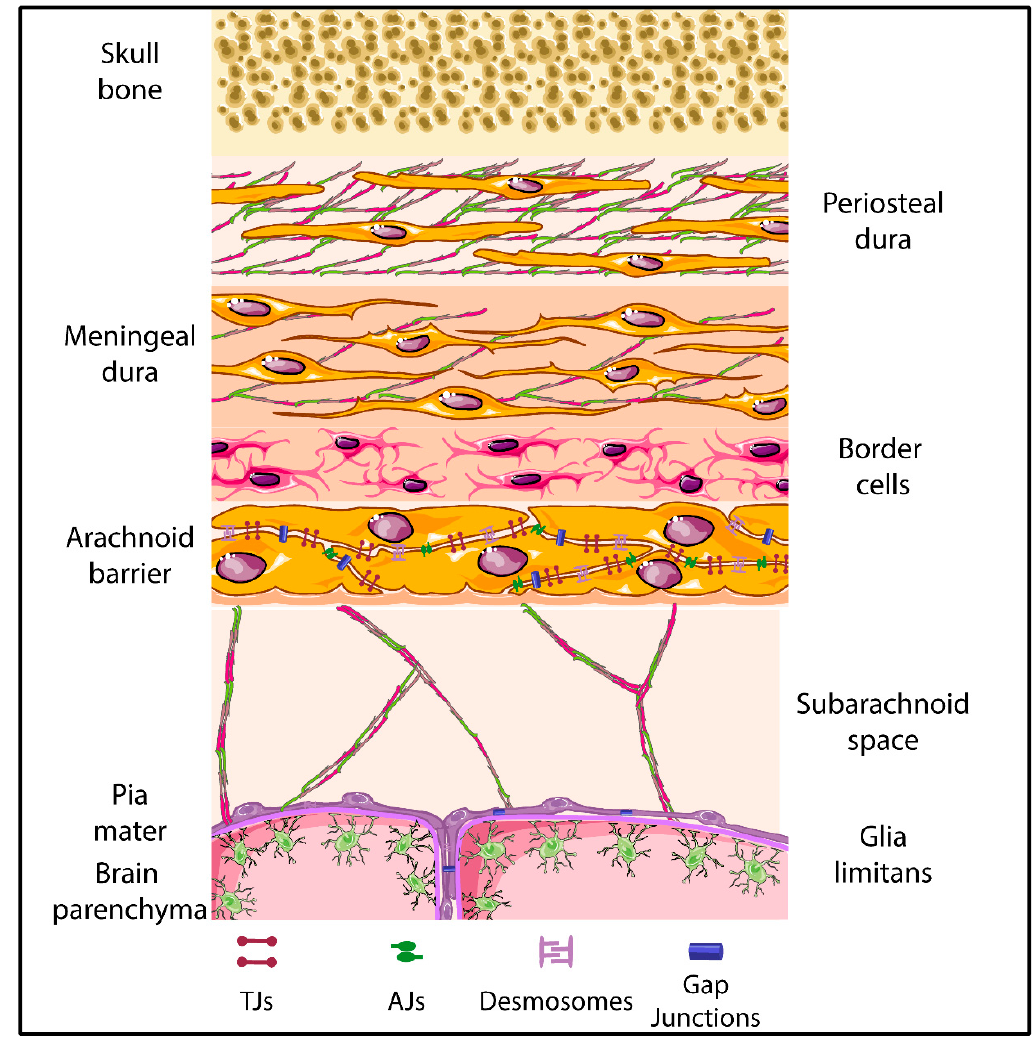
Figure 4. Schematic representation of the meningeal layers. The different layers and cellular composition of the meningeal layers are displayed. Tight junctions are highlighted between the arachnoid barrier cells as parallel lines, with adherens junctions, desmosomes and gap junctions also being represented. The shapes of the cell types were adapted from Servier Medical Art (http://smart.servier.com/), licensed under a Creative Common Attribution 3.0 Generic License.